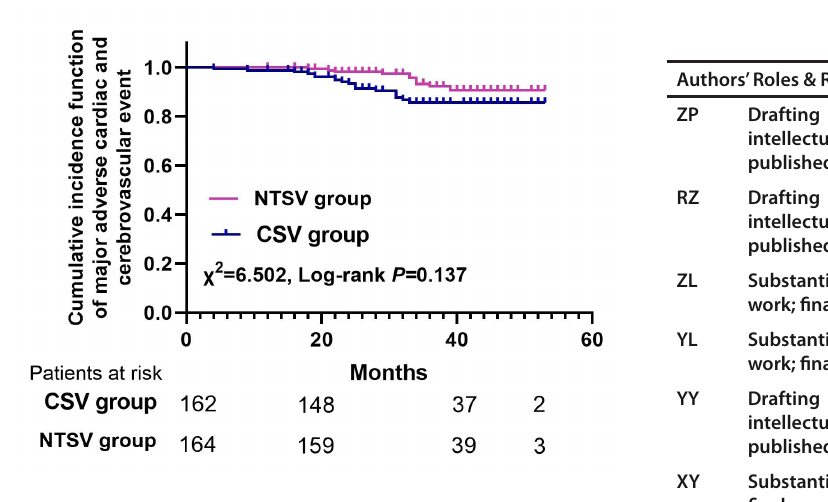
Fig. 4 - The cumulative incidence function of major adverse cardiac and cerebrovascular event between the conventional saphenous vein (CSV) harvesting technique group and the no-touch saphenous vein (NTSV) harvesting technique